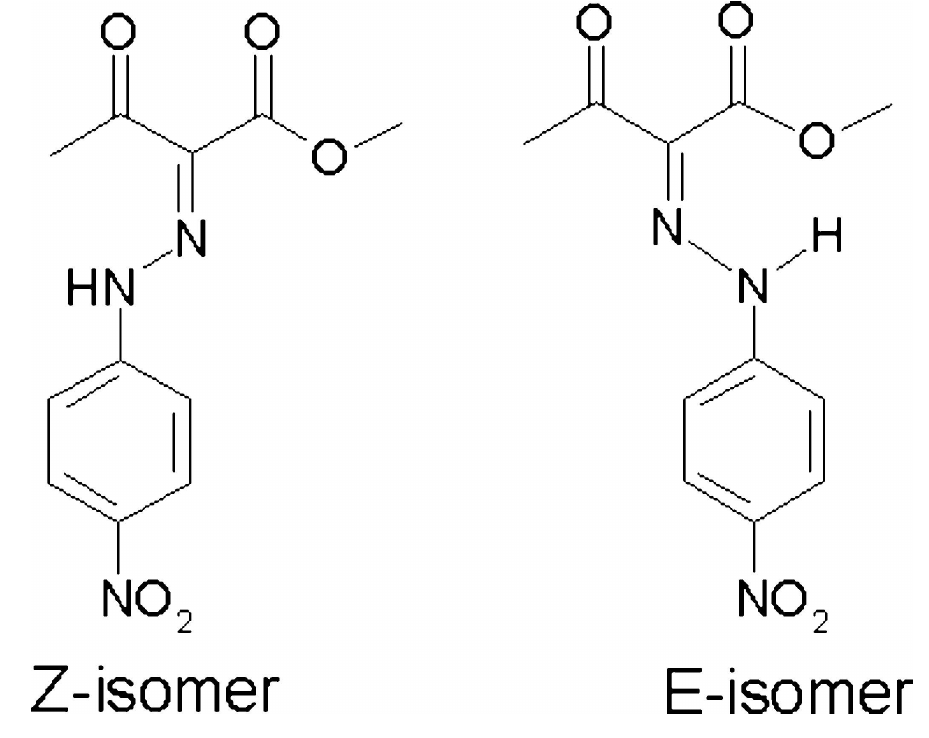
Figure 4 The E and Z isomers of the title